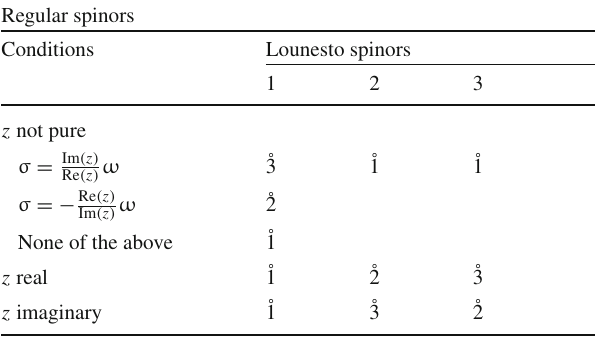
Table 2 Correspondence between regular classes